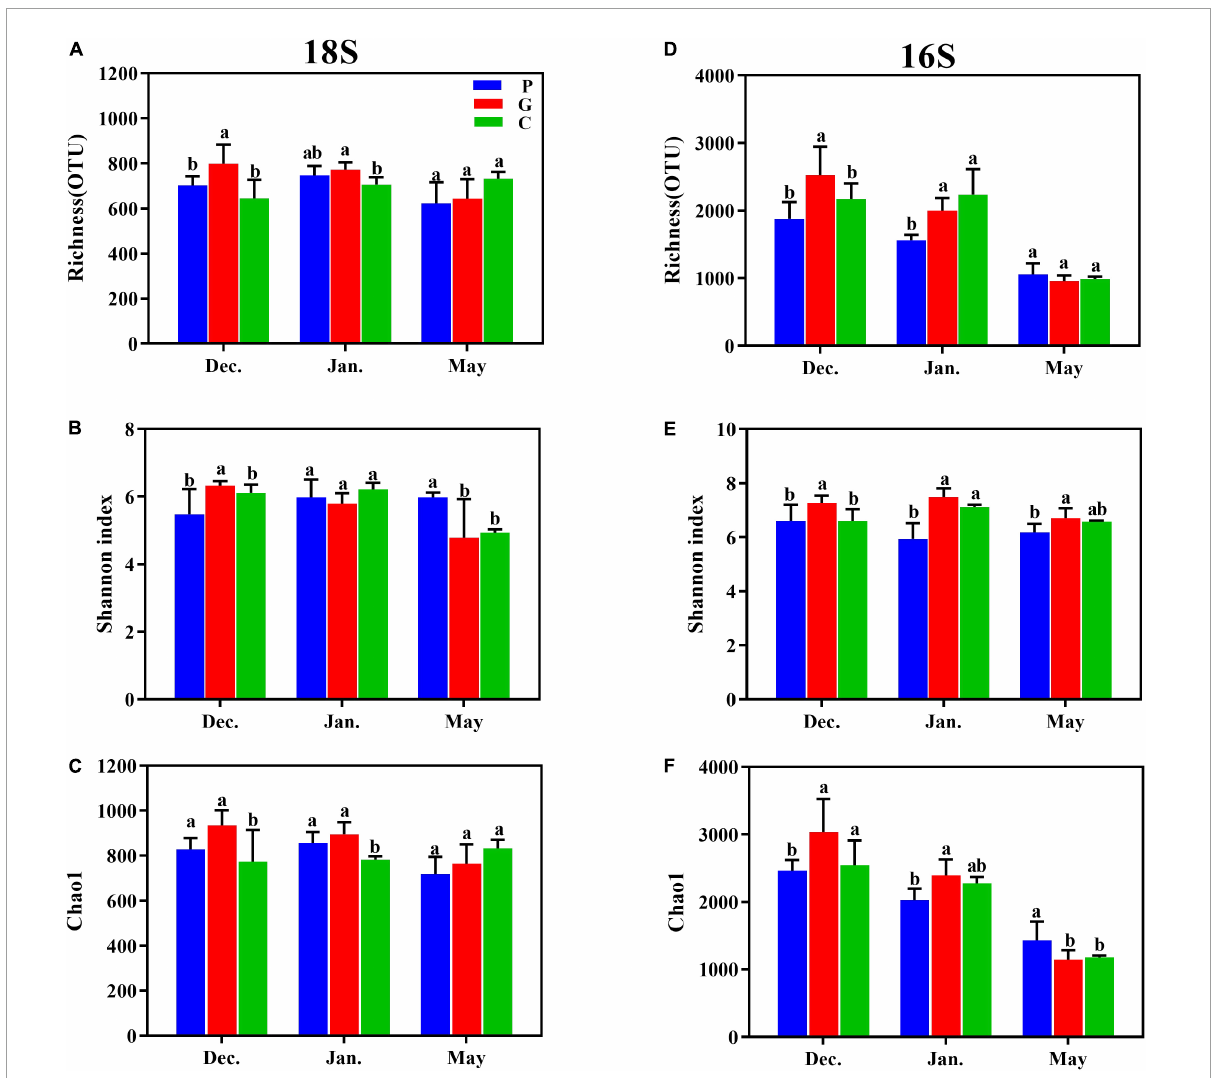
FIGURE2 Effects of seaweed cultivation on the alpha-diversity indexes. The observed number of OTUs based on 18S (A) and 16S (D) , the Shannon index based on 18S (B) and 16S (E) , and the Chao1 index based on 18S (C) and 16S (F) shows the alpha diversity of microbial communities across different cultivation periods at the three study sites. Different letters (a, b) represent significant differences ( p -value < 0.05) in mean value among zones C, P, and G by